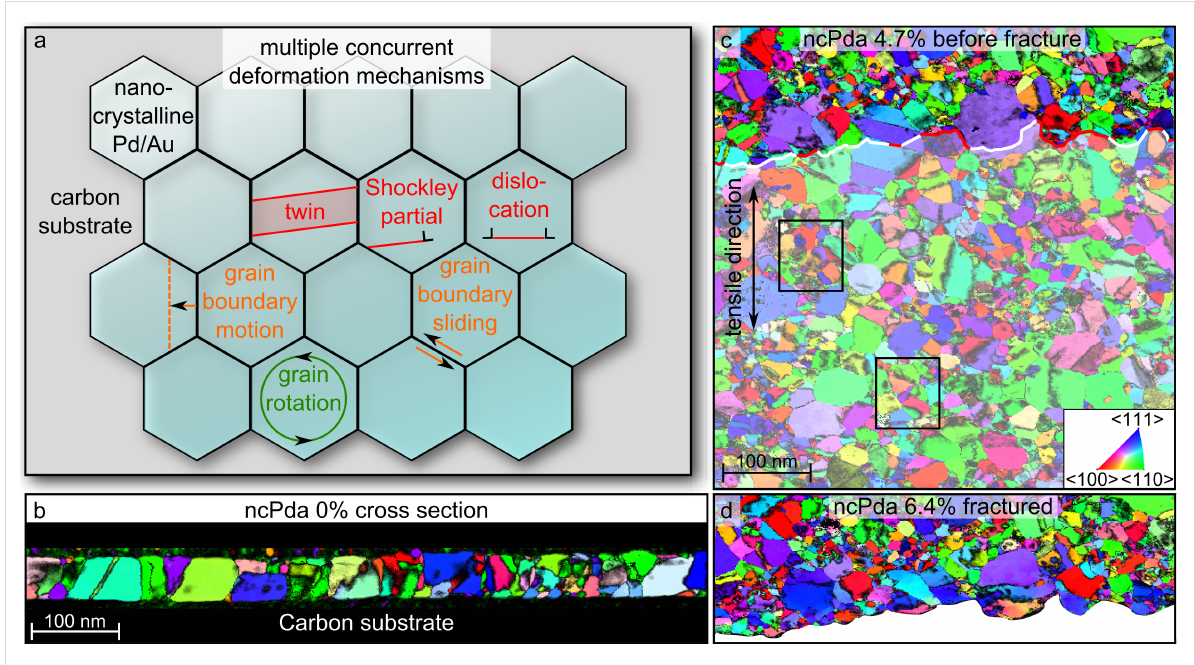
Figure 1: (a) Sketch showing multiple concurrent deformation mechanisms. (b) ACOM-STEM orientation maps overlaid with the reliability and the cross-correlation index of a cross-section of ncPda at 0% strain. (c,d) ACOM-STEM orientation maps overlaid with the reliability of the fracture mor- phology of ncPda before (c) and after fracture (d). The crack line of (d) is overlaid in (c) to reveal the crack behavior. Red parts of the crack line indi- cate fracture along grains boundaries and white lines indicate cracks passing through grains. The projection direction is along the tensile direction and the color code is given in (c). The black boxes in (c) indicate the areas of the detailed analysis in Figure 2 and Figure